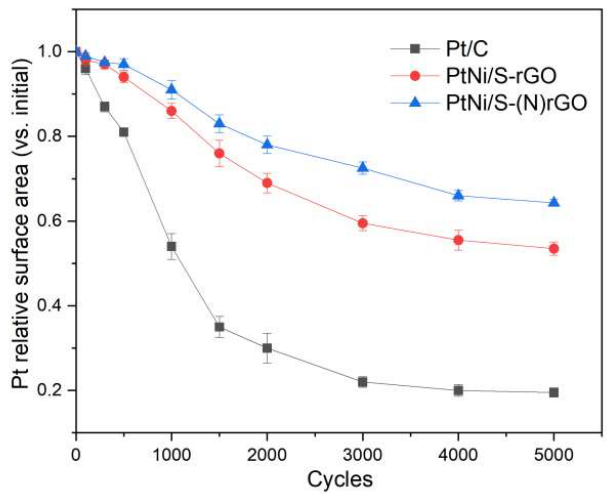
Figure 7. Changes of ECSA of three catalysts with different cycles under the same electrochemical acceleration test.